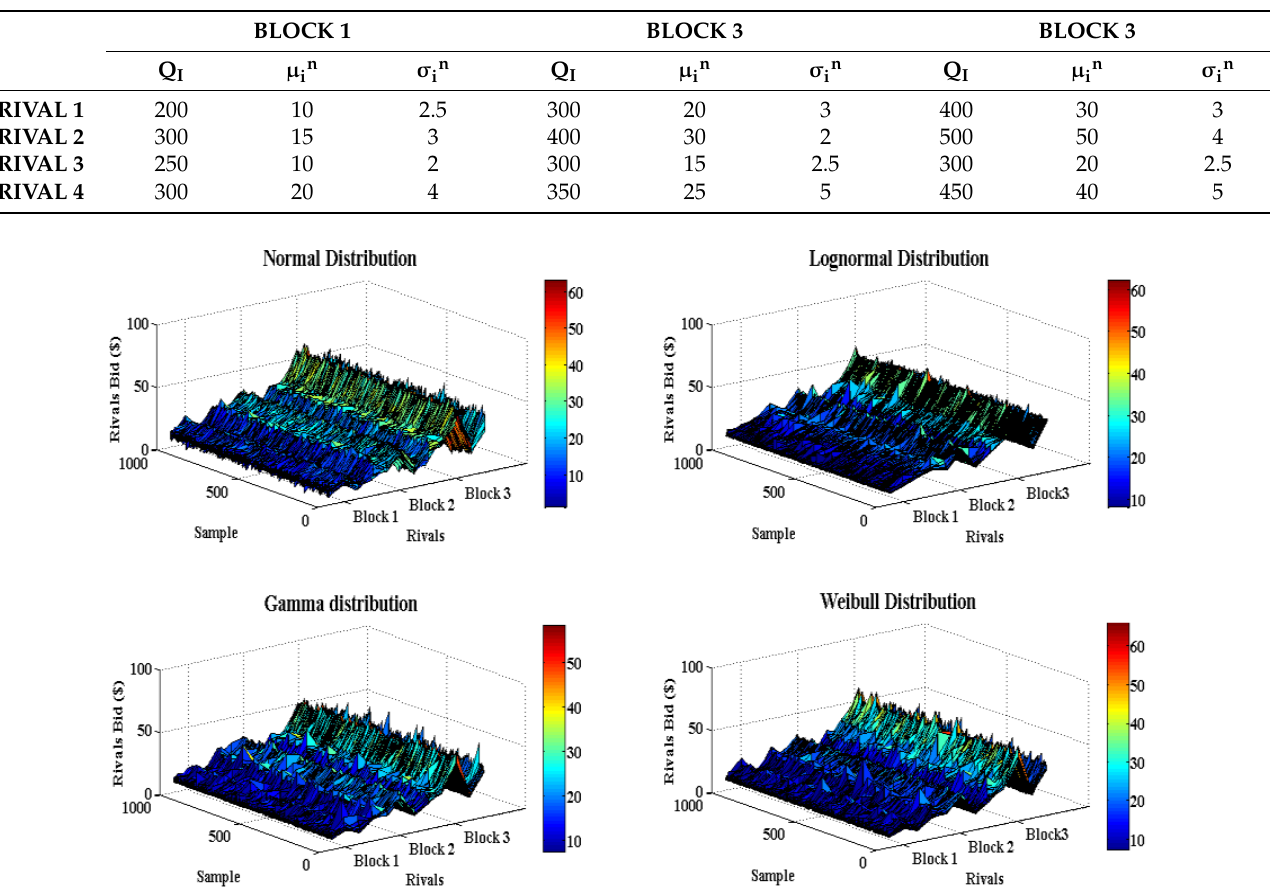
Table 1. Data of Competitor’s Bidding Parameters.